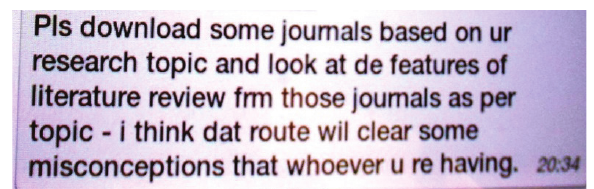
FIGURE 2: Example 2 of student functioning.